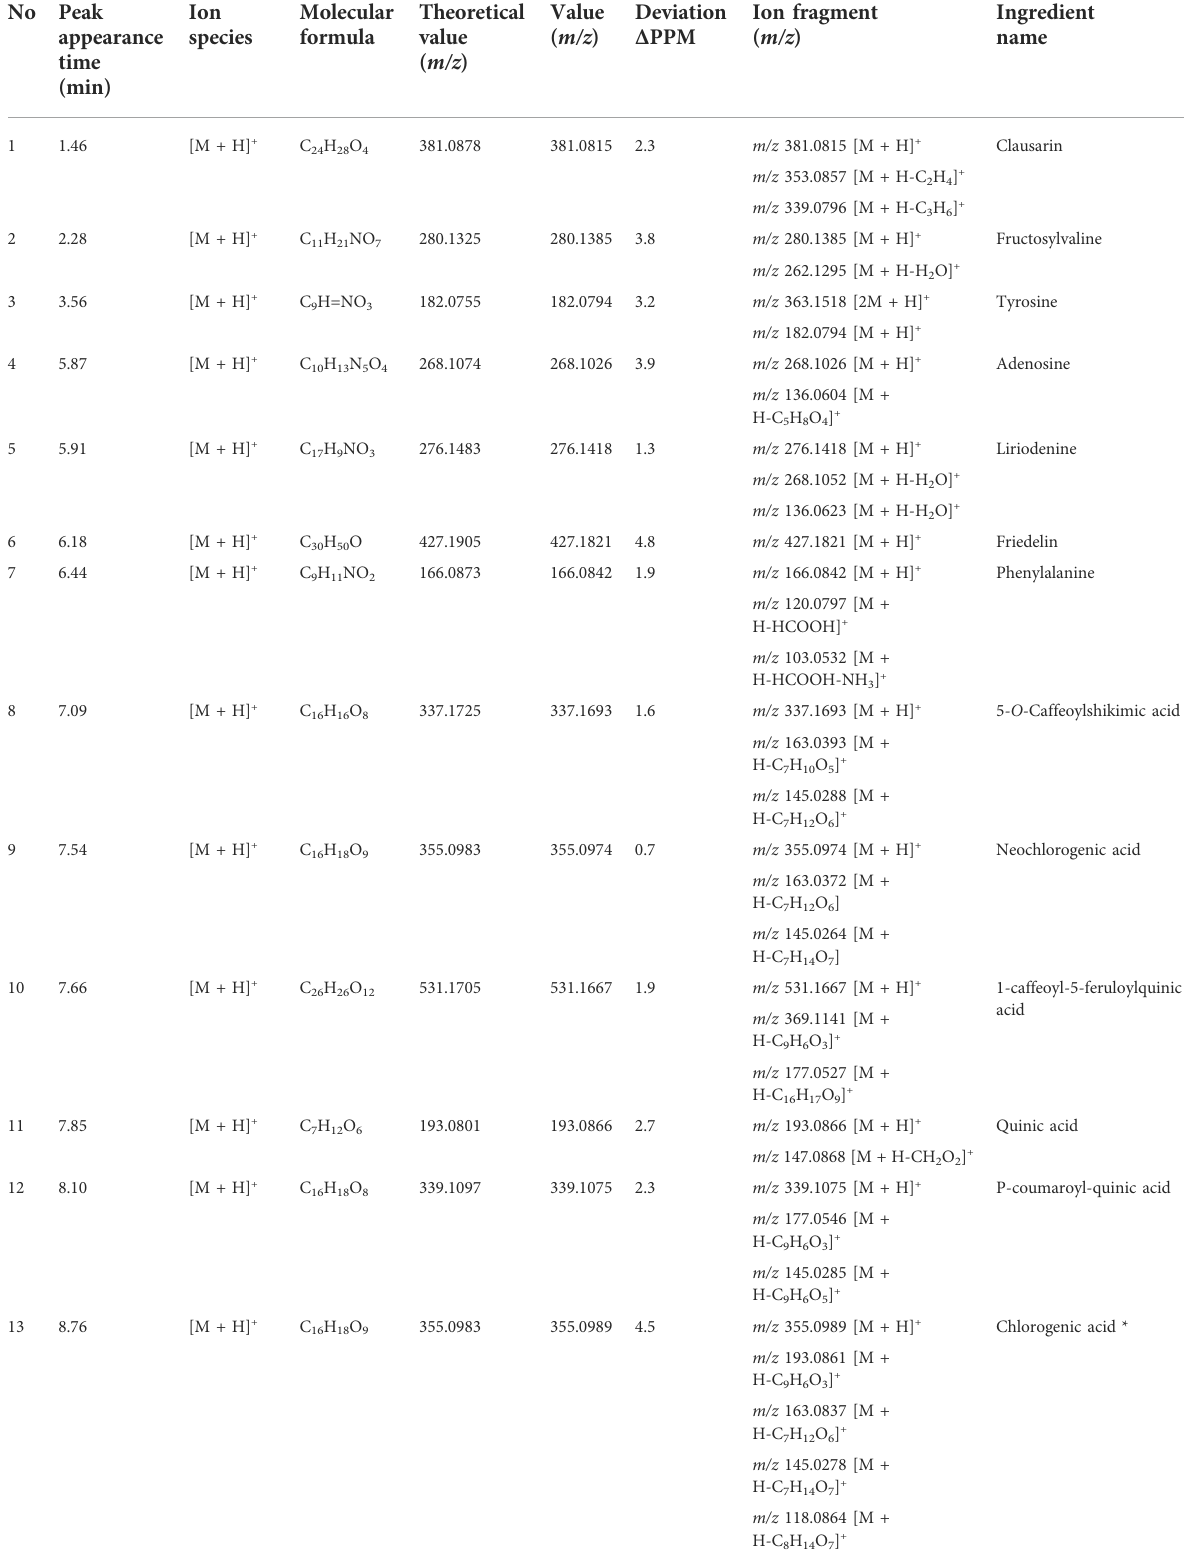
TABLE 1 Ingredients identi fi ed in CWT based on UPLC-Q-TOF